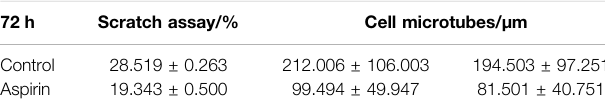
TABLE 4 | The average healing rate of 72 h scratch assay and 72 h cell migration range on microtubes in aspirin groups. 72 h Scratch assay/%